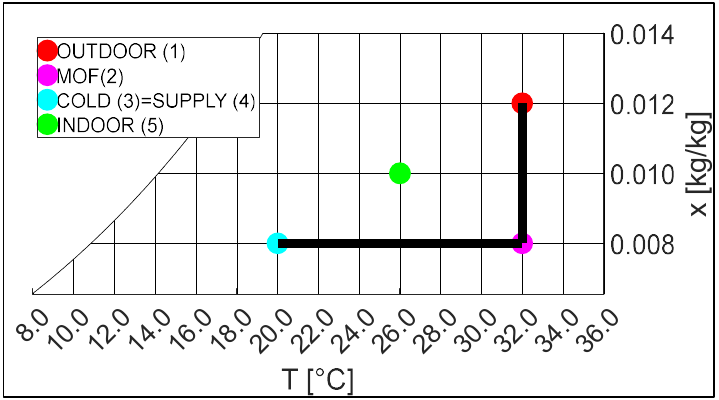
Figure 5. Transformations in a HVAC system with MOF-assisted dehumidification.